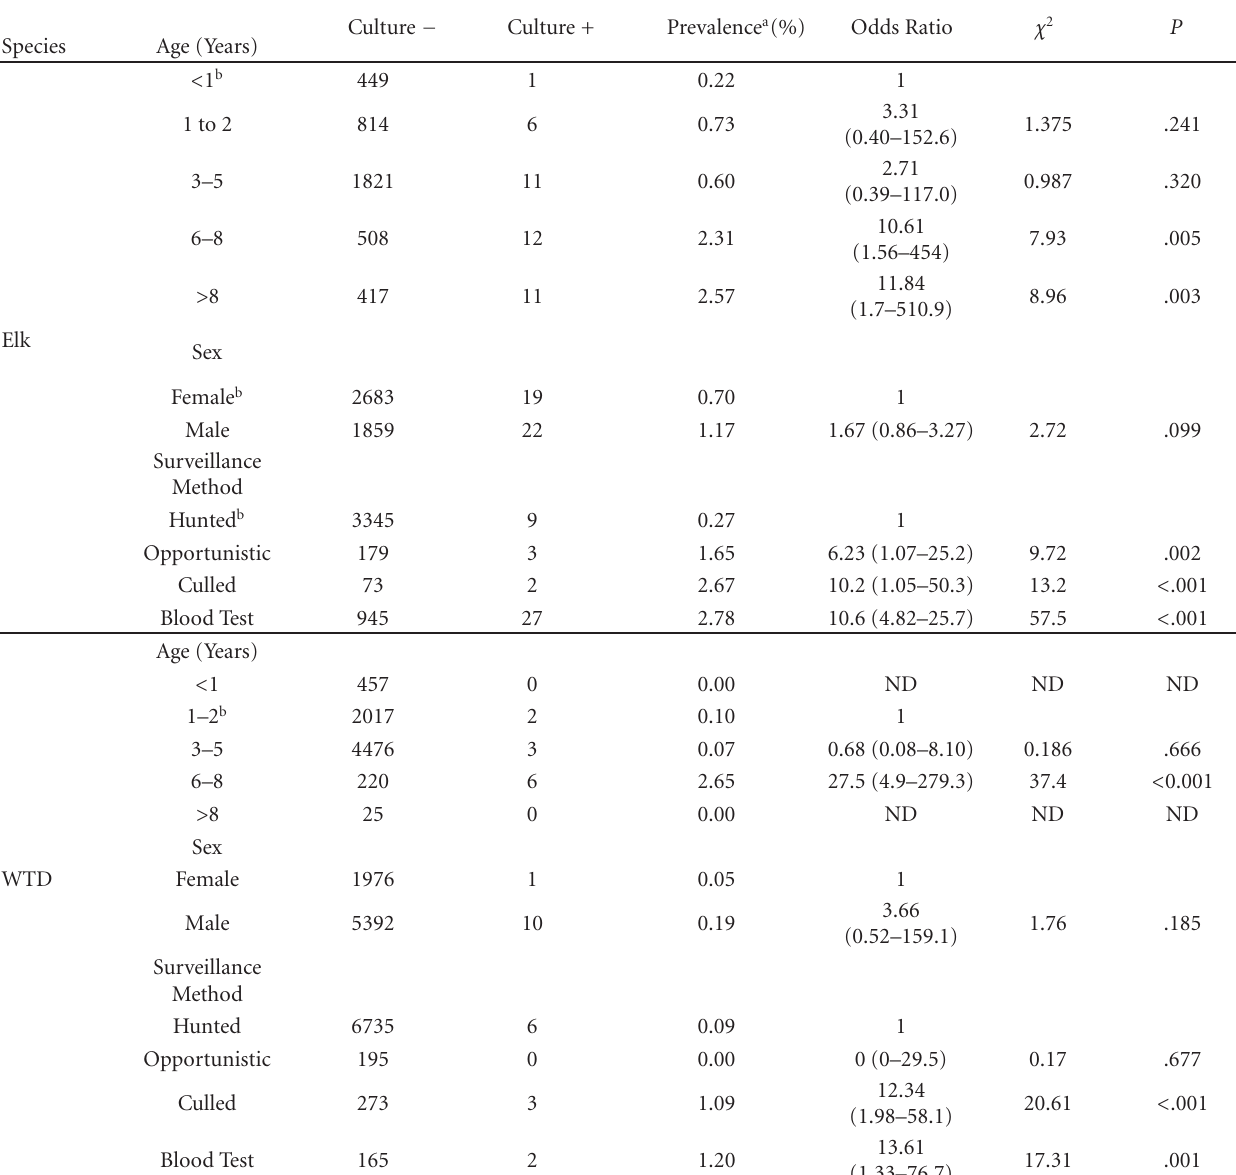
Table 5: Prevalence of M. bovis in elk and white-tailed deer (WTD) stratified by sex, age category, and surveillance method from south- western